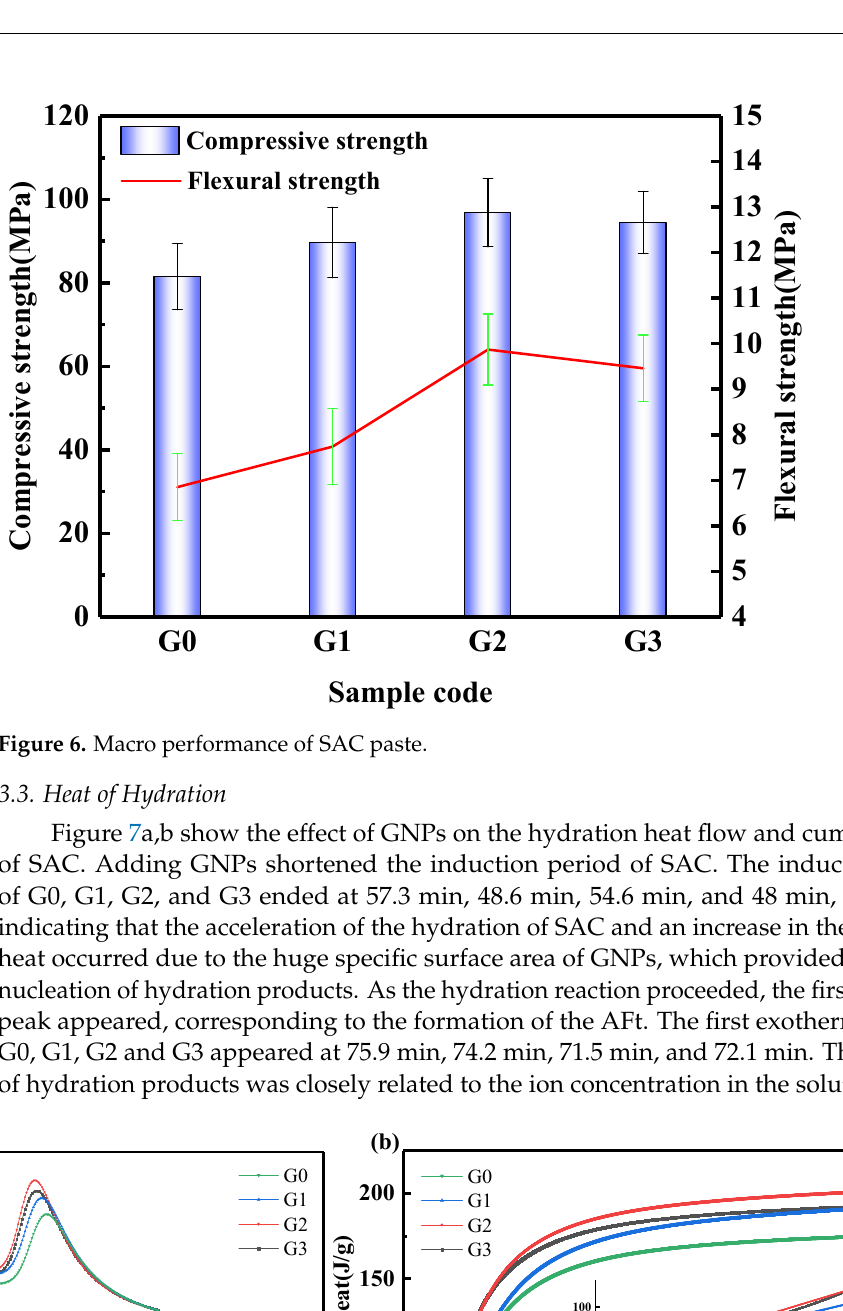
Figure 8. ICP results of sulfoaluminate cement paste. 3.4. XRD and TG ‐ DTG Analysis Figure 9 shows the samples’ XRD patterns of AFt, AH 3 , C 4 A 3 Š, C 2 S, and gypsum. It was found that after adding GNPs, the peak positions of different samples were the same, and no new diffraction peaks appeared, but the peak intensities were different. The peak intensity of the AFt in the GNPs group is higher than that of the G0 group, indicating that GNPs promoted the hydration of SAC, which is consistent with other studies that found